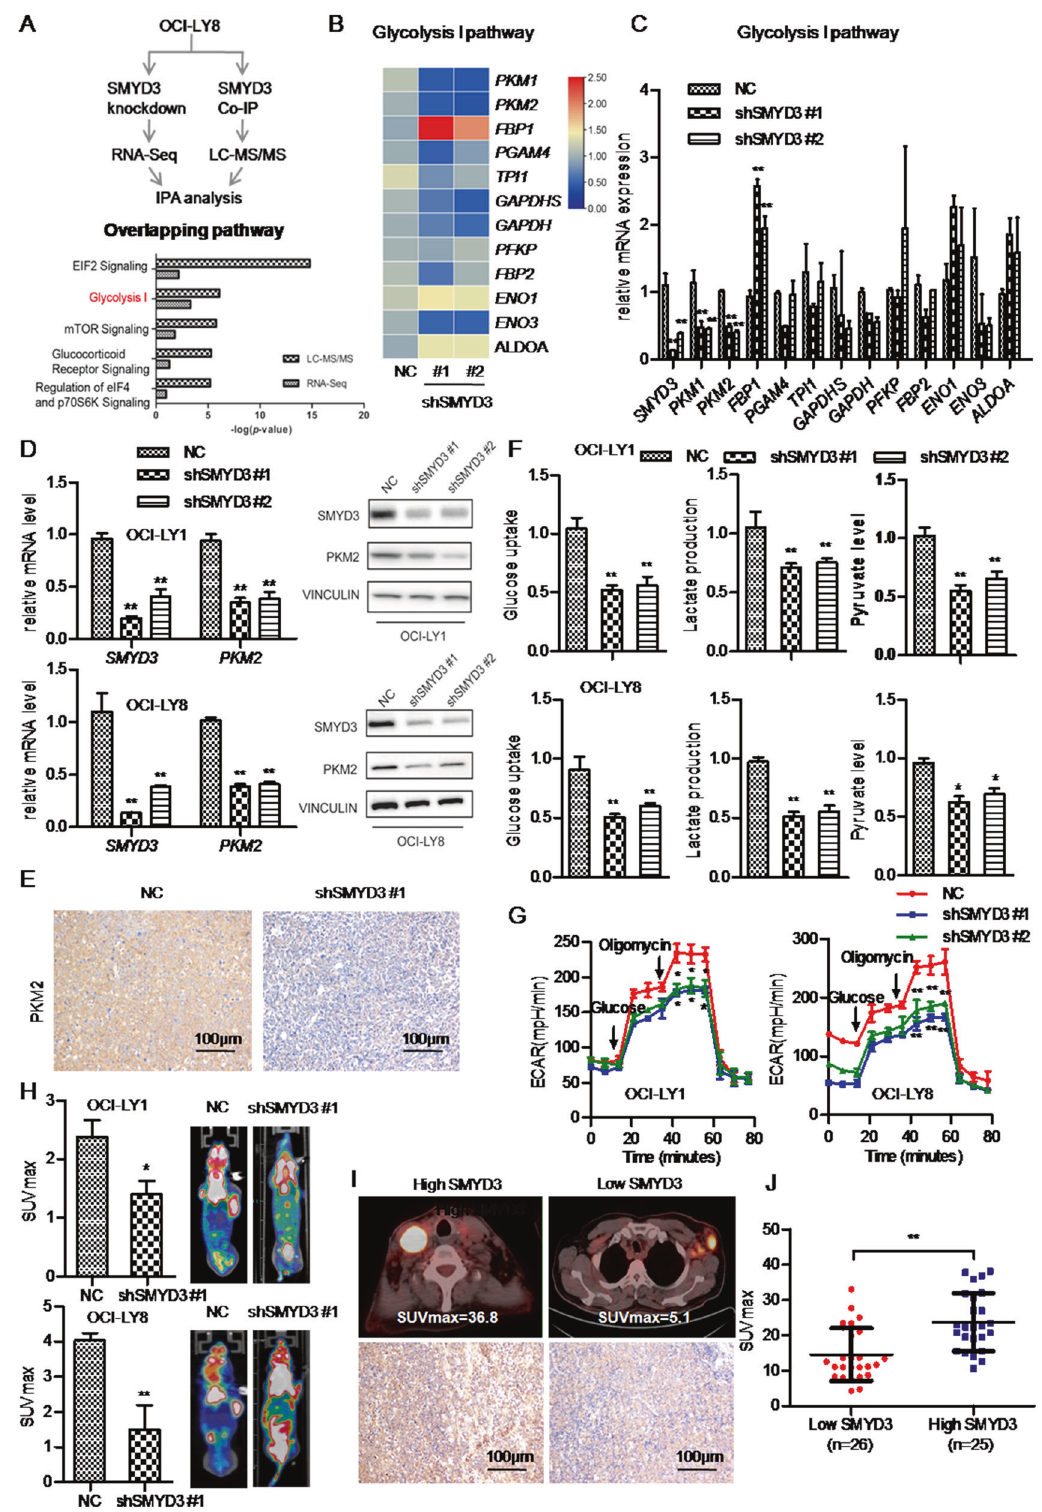
had strong PKM2 staining (Fig. 5A). Spearman ’ s correlation analysis showed that PKM2 protein expression in 166 DLBCL cases was positively associated with that of SMYD3 (R = 0.3673, P < 0.0001; Fig. 5B). Patients with DLBCL and high PKM2 protein expression levels were more likely to relapse or die within two years ( P = 0.046; Table S4). Kaplan-Meier curves showed that high